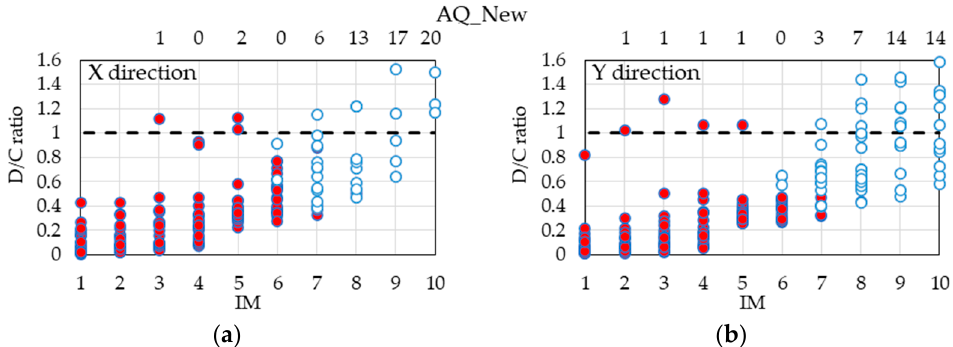
Figure 13. Displacement D/C ratios of the superstructure (UPD): AQ_New X ( a ) and Y ( b ) directions.